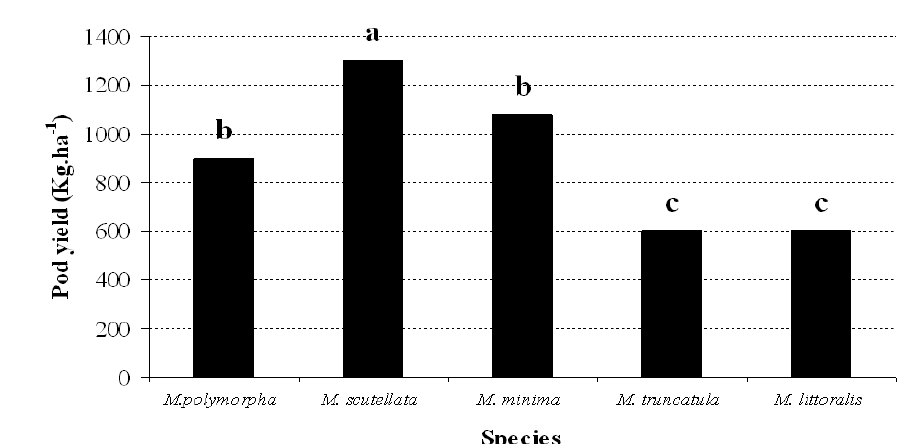
Fig. 5. Main effects of species on pod yield. All the values followed by the same letter in each column are not statistically different at the p<0.05 probability